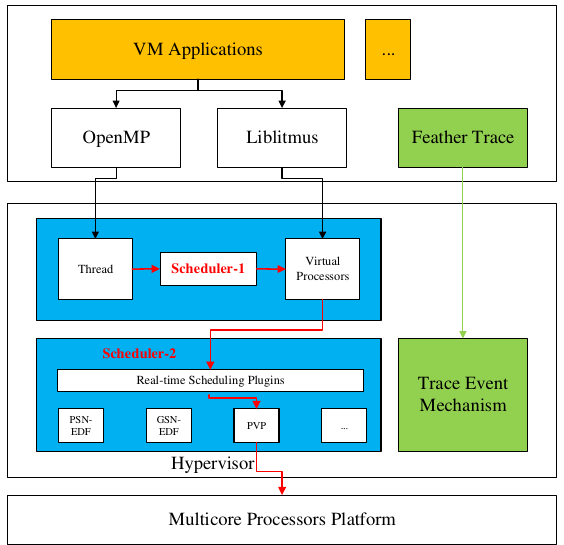
Figure 5. The architecture of virtualization platform.